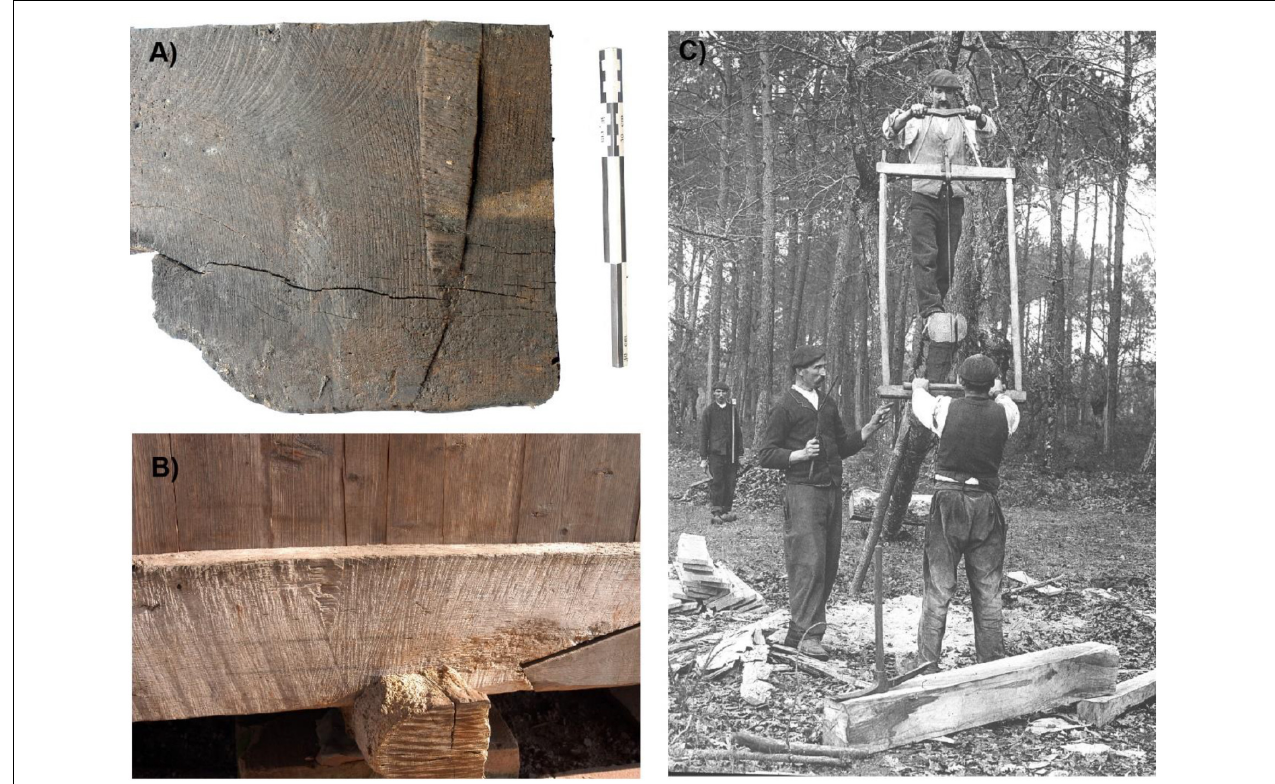
FIGURE 9 | Longitudinal sawing of planks and boards. (A) Oak board with a characteristic “V” saw mark from the Roman harbor in Reims, France (1st century CE) and (B) sawing marks with a characteristic “V” mark on a beam from a historical building in Le Val-d’Ajol, France (18th century CE). (C) Historical postcard from La Baconniˇcre, France, depicting the sawing